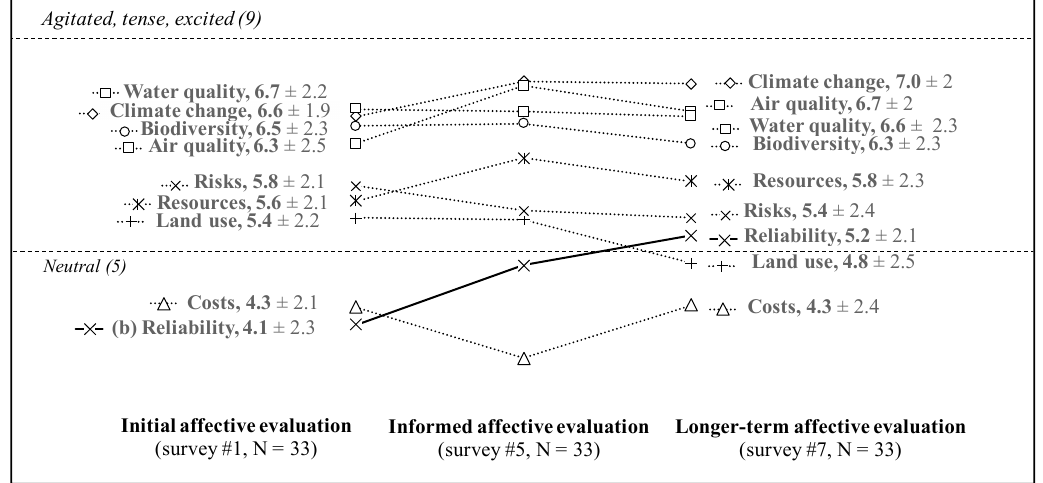
Figure 5. Average affective evaluations of impacts by the citizen panel (nine-point Likert scale, 1 = calm, relaxed to 9 = excited, tense, agitated). Statistically significant differences ( p < 0.05) are: (b) between survey #1 and survey #7. The informed feelings are: water quality = 6.7 ± 1.9, climate change = 7.1 ± 1.9, biodiversity = 6.5 ± 2.1, air quality = 7.0 ± 1.9, risks = 5.5 ± 2.6, resources = 6.1 ± 2.2, land use = 5.4 ± 2.6, costs = 3.7 ± 2.2, and reliability = 4.8 ± 2.2.